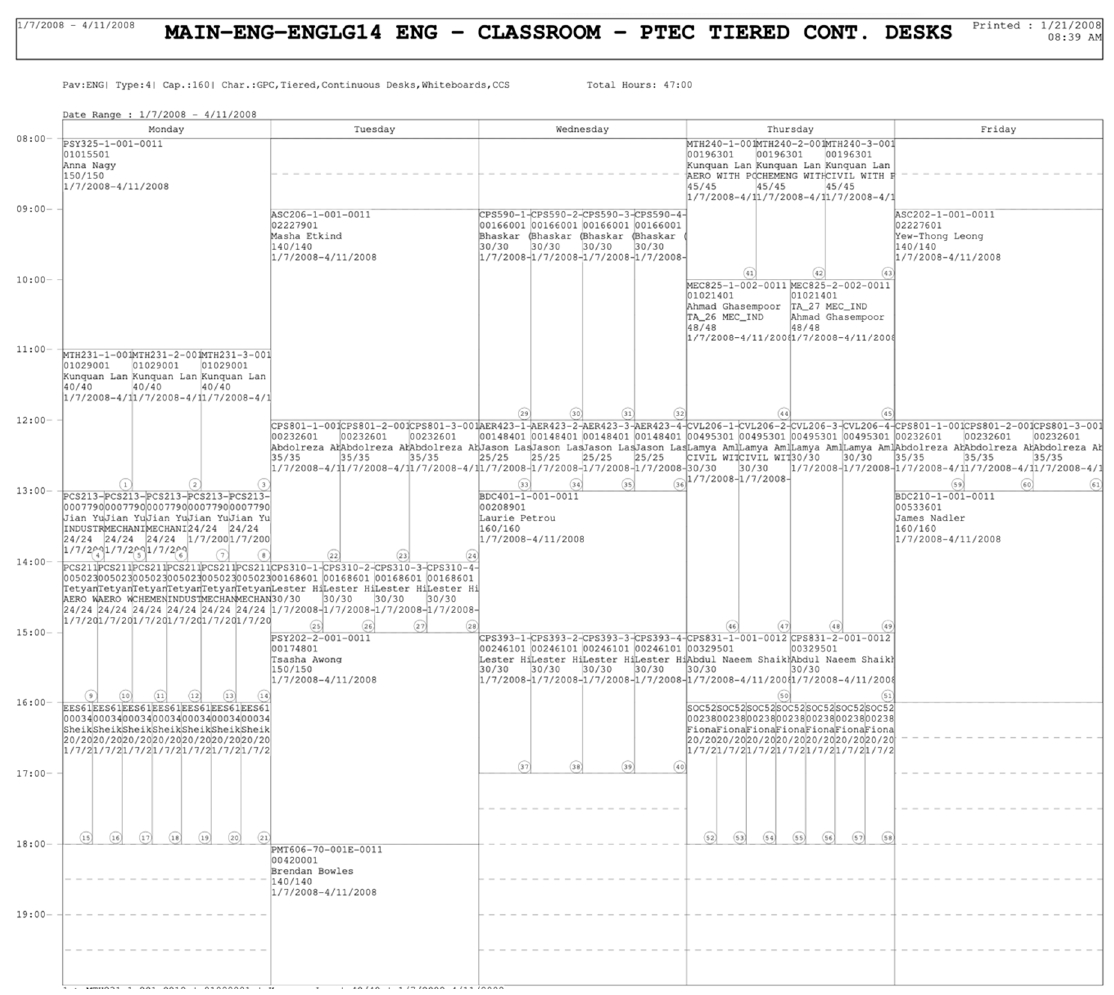
Figure A5. Weekly Lecture Schedule and Expected Occupant Numbers in the Classroom.